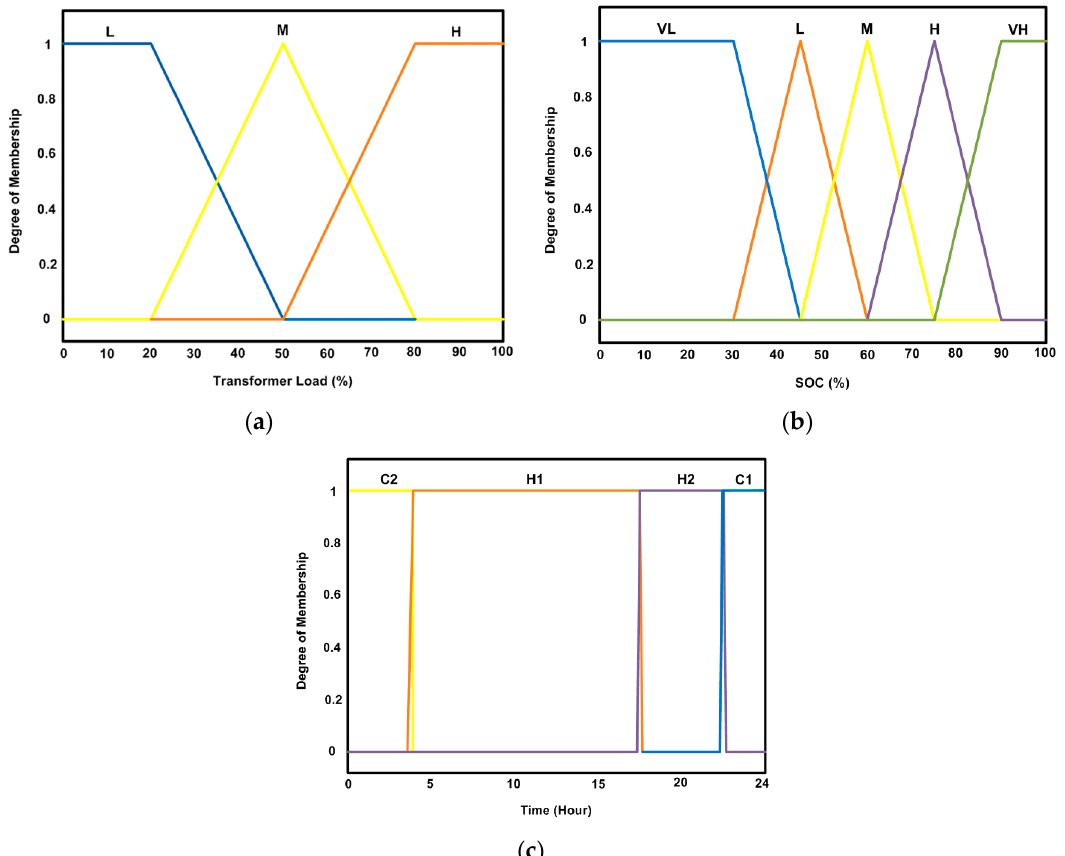
Figure 2. Fuzzy logic Inputs ( a ) transformer load level, ( b ) SOC, and ( c ) discount time.